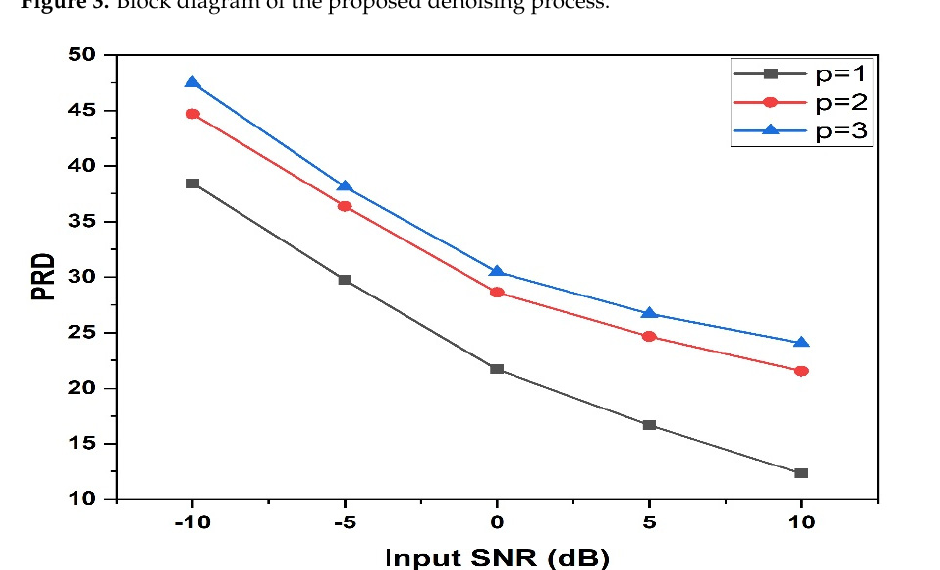
Figure 4. Performance comparison for noise order for record 100.